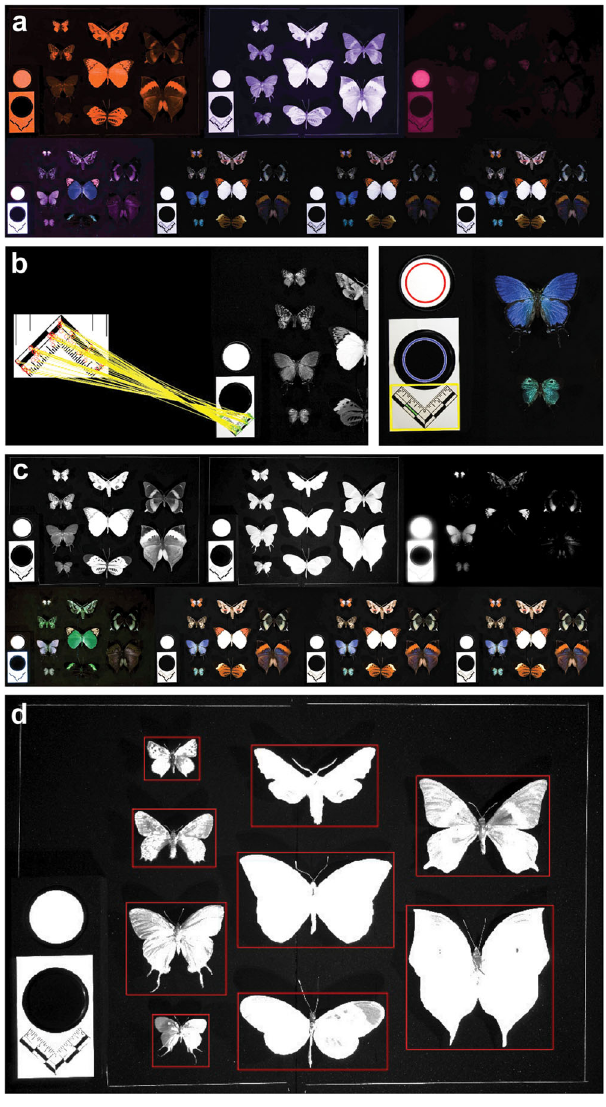
Fig. 3 Imaging processing pipeline for each unit (a set of seven drawer images). a A set of seven raw images in NEF format; b Automatic recognition of the scale bar and standard white and black references; c Re fl ectance calibration according to the standard white and black references; d Individual specimen images are extracted by red bounding